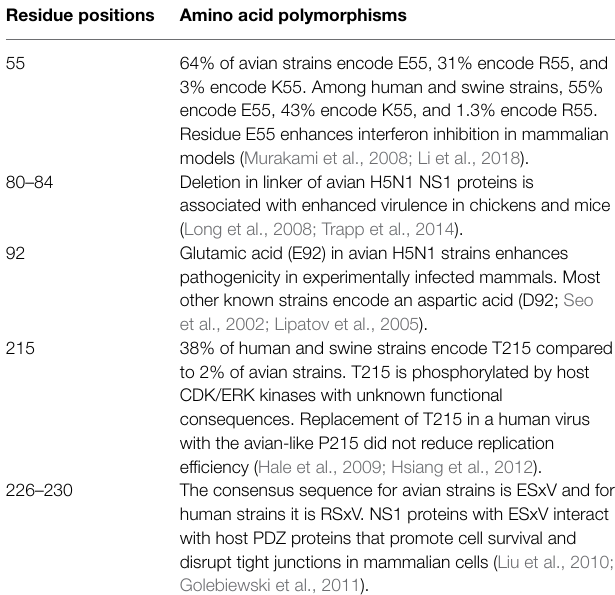
TABLE 1 | Species-associated NS1 polymorphisms with investigated functional